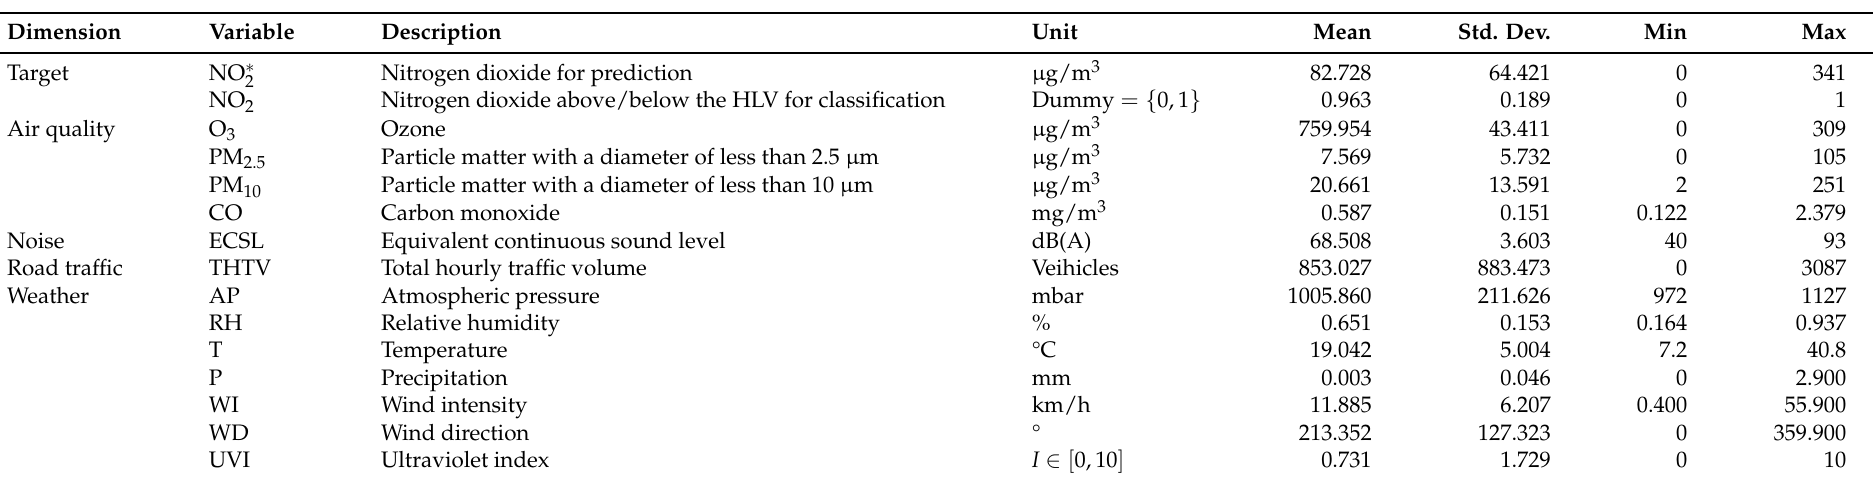
Table 1. Summary statistics.